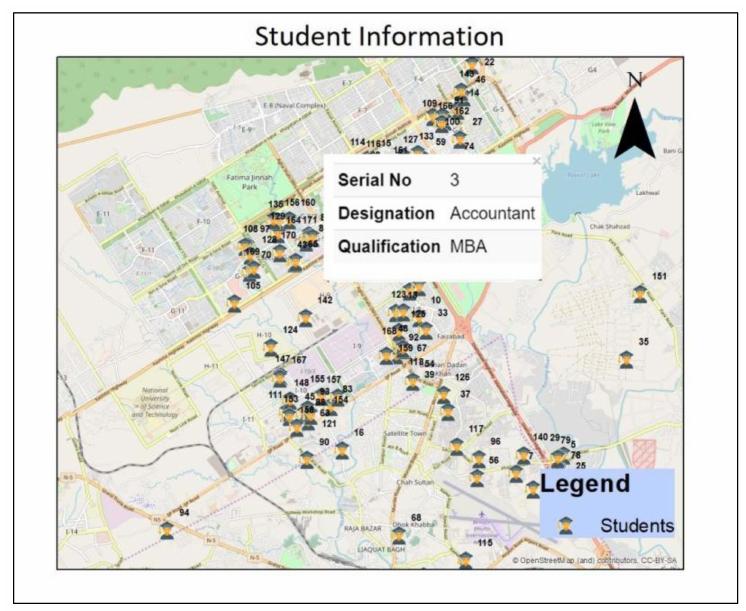
Figure 4. Student information.